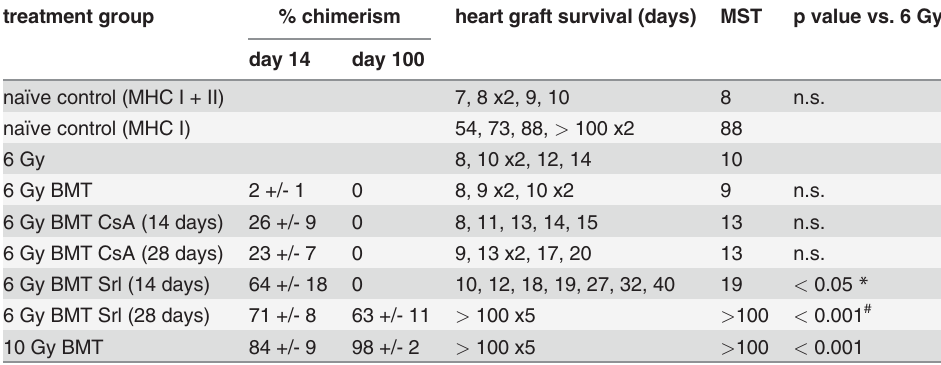
Comparing the application of Srl for 14 and 28 days after 6 Gy of TBI and BMT a signifi- cant prolongation of heart graft survival was observed for the application of Srl for 28 days (p < 0.001). come residual alloreactivity could be assumed.